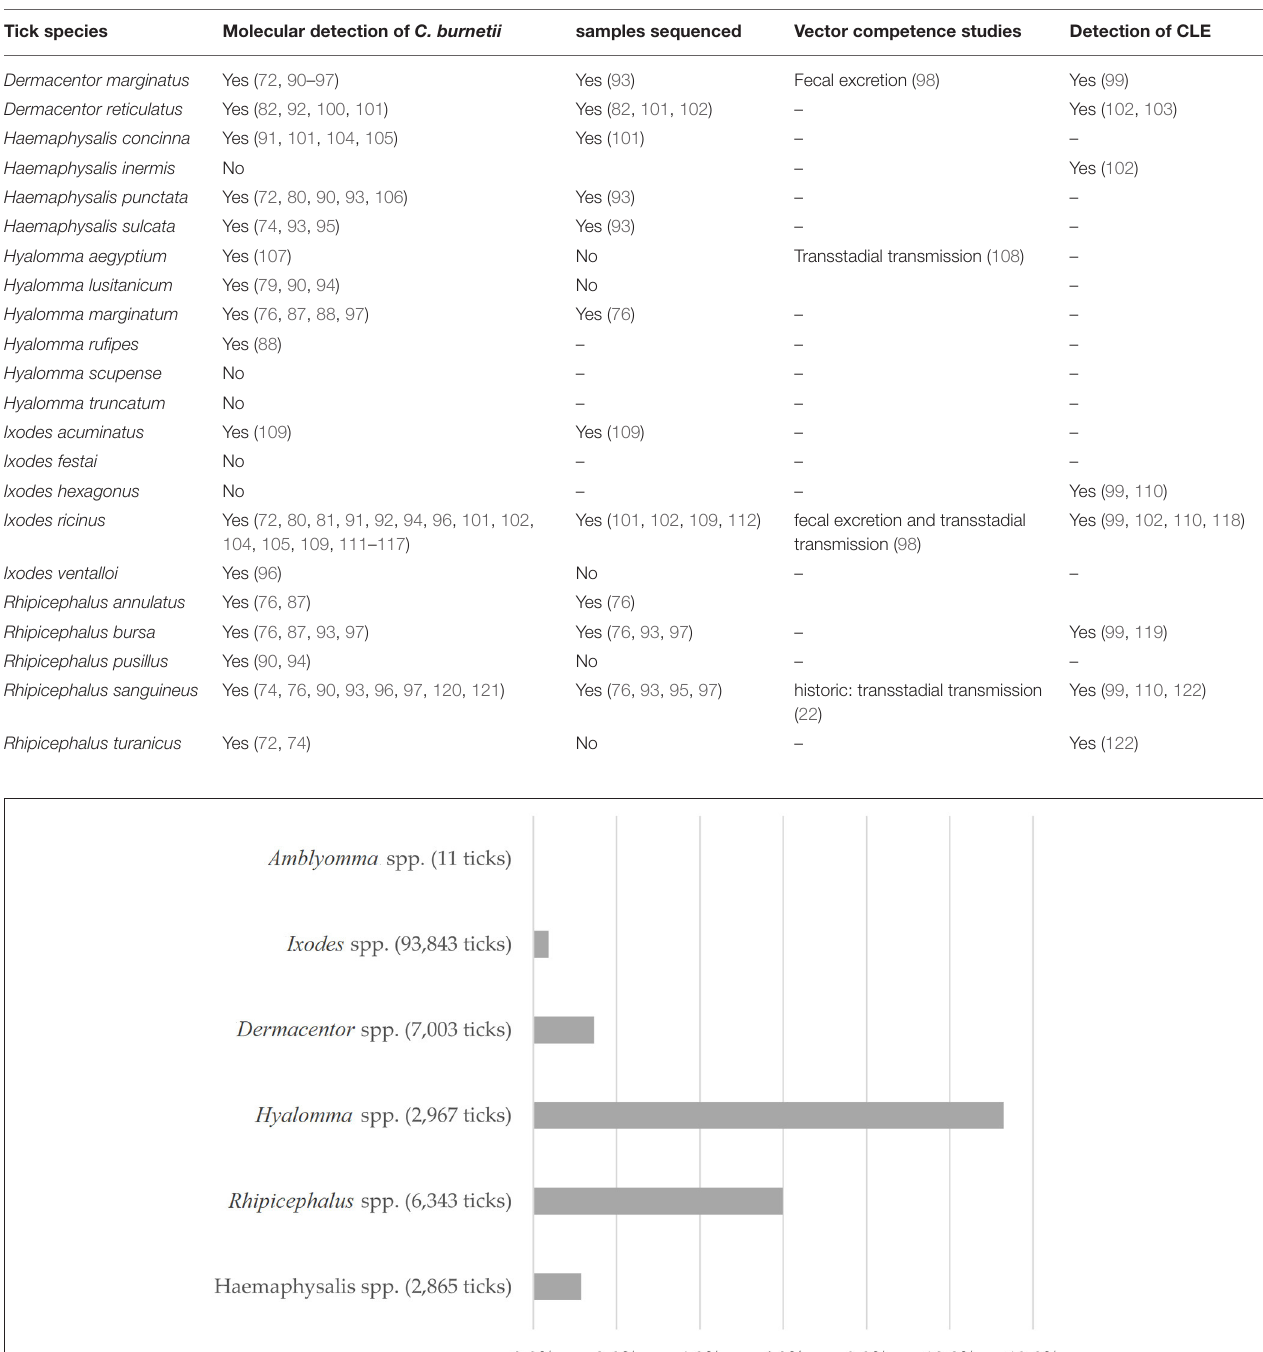
TABLE 1 | Selected tick species collected in Europe and detection of C. burnetii and CLE (Reference). Tick species Molecular detection of C. burnetii samples sequenced Vector competence studies Detection of CLE